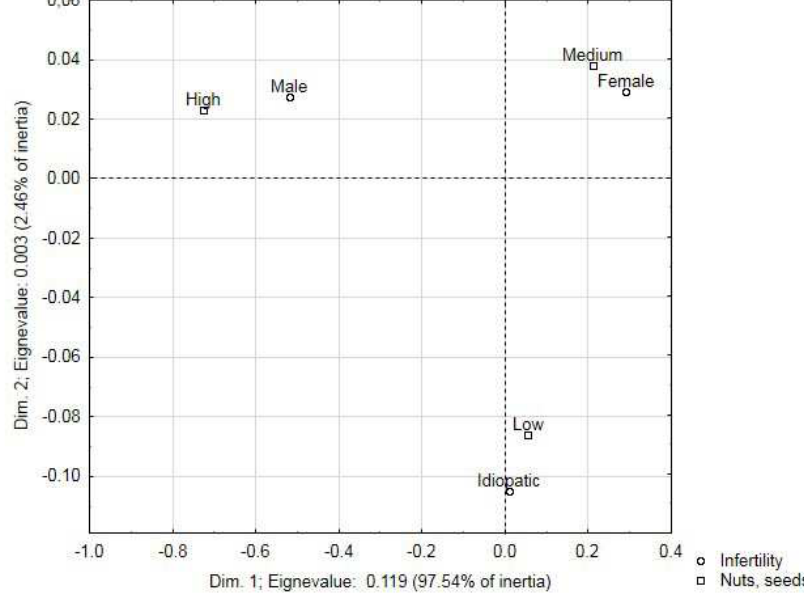
Figure 4. Correspondence map: cause of infertility vs. consumption of nuts and